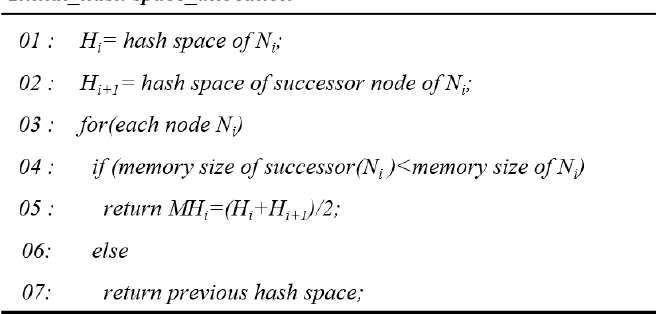
Figure 5. Initial node allocation algorithm.